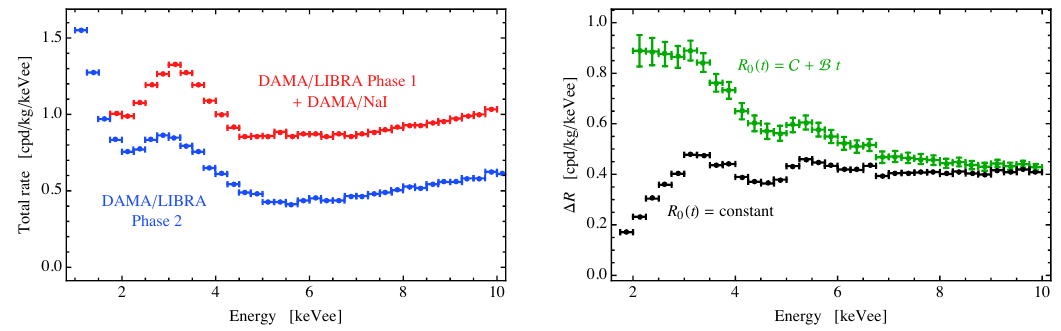
Figure 9 . Left: rate averaged over all data-taking time for DAMA/LIBRA Phase 2 (blue points), and for DAMA/LIBRA Phase 1 and DAMA/ NaI combined (red points). Right: di(cid:11)erence in the total rate between the end of Phase 1 and the beginning of Phase 2, calculated assuming both a constant rate (black points), and a background that linearly grows with time (green points). In the latter case the values of B and C are chosen in order to reproduce the modulated signal and the cumulative rates; the errors come from the uncertainty in the